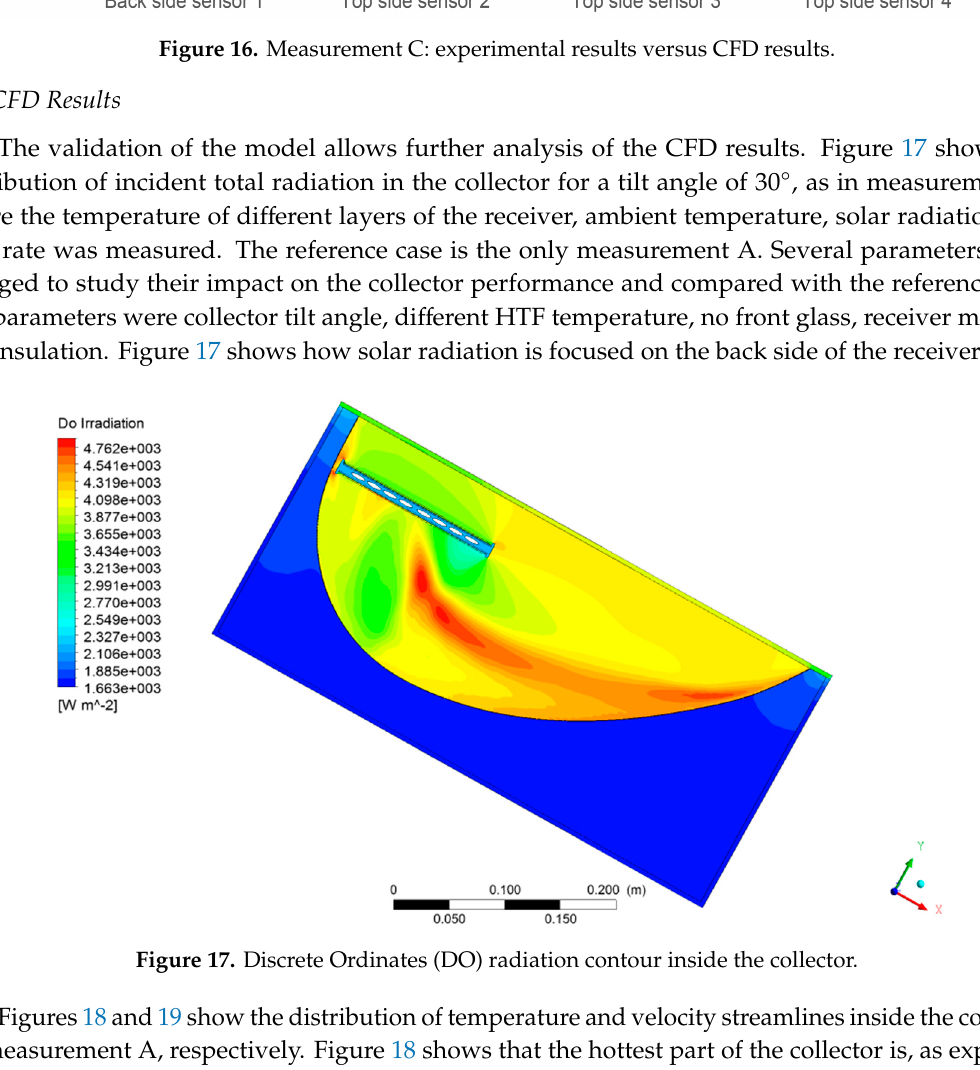
Figure 16. Measurement C: experimental results versus CFD results.